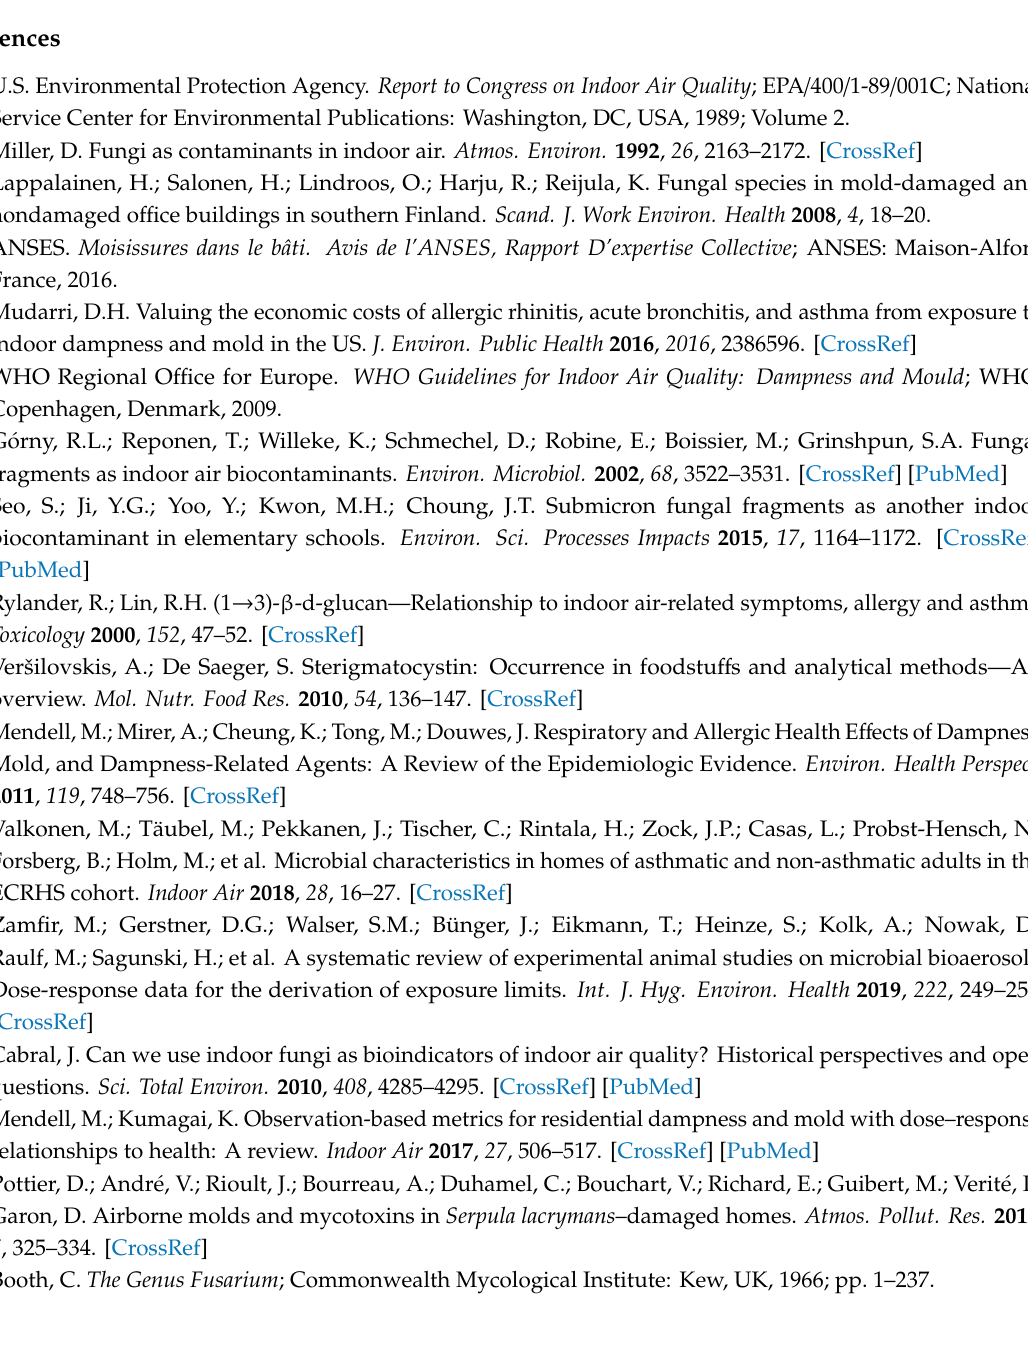
Table S1: List of the di ff erent molds quantified in the bioaerosols of mold-damaged homes (n =